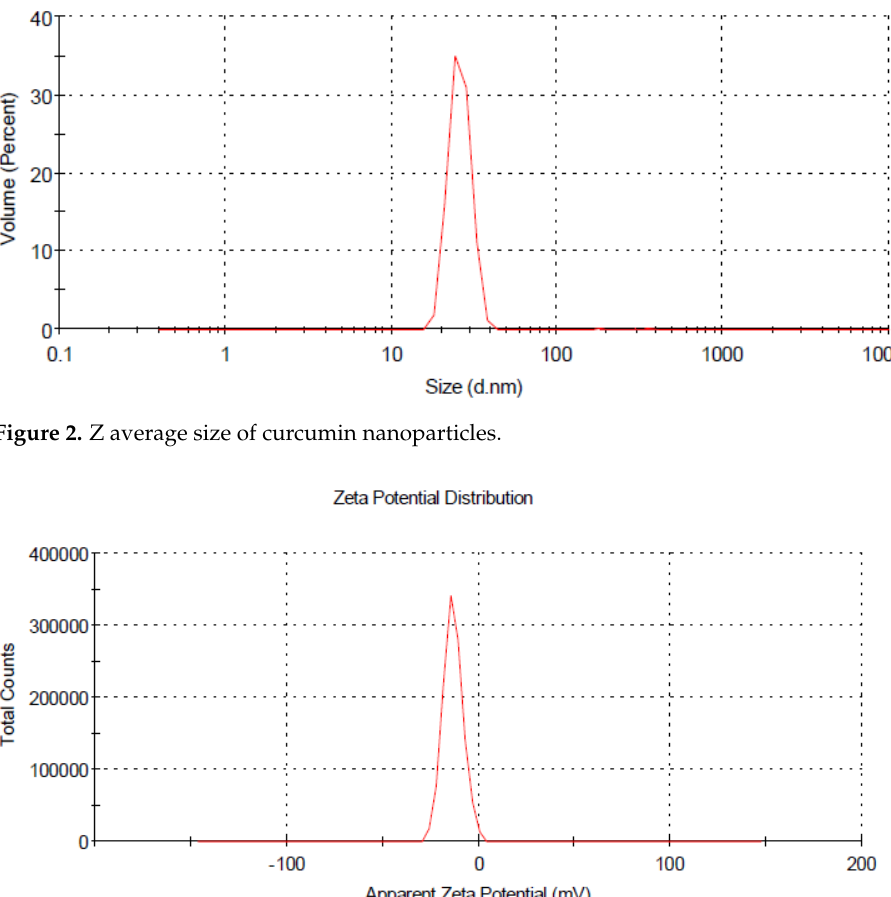
Figure 4. Z average size of Glycyrrhizic acid nanoparticles. Figure 5. Zeta potential for Glycyrrhizic acid nanoparticles.